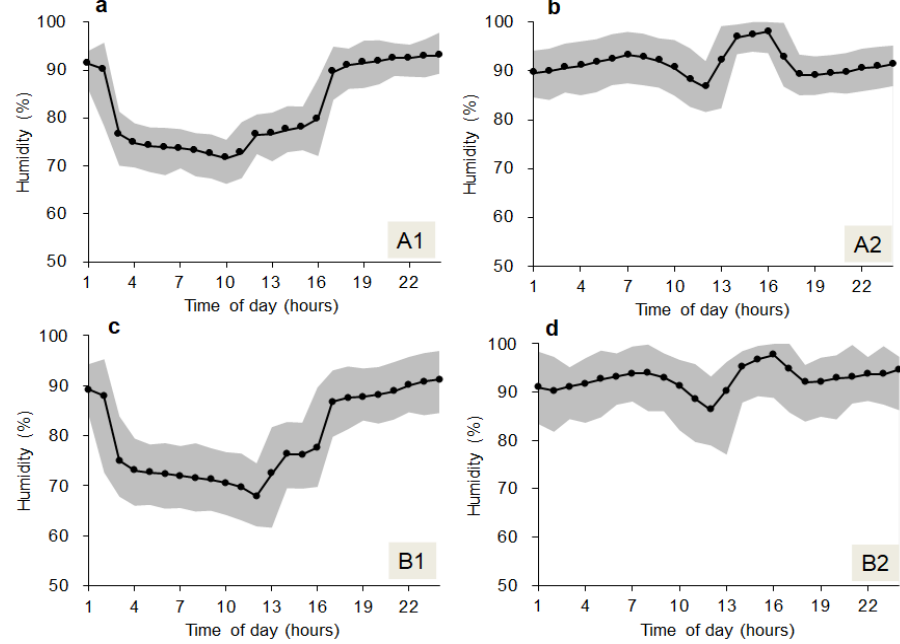
Figure 16. Variation in temperature in cultivation zones ( a ) A1, ( b ) A2, ( c ) B1, and ( d ) B2.